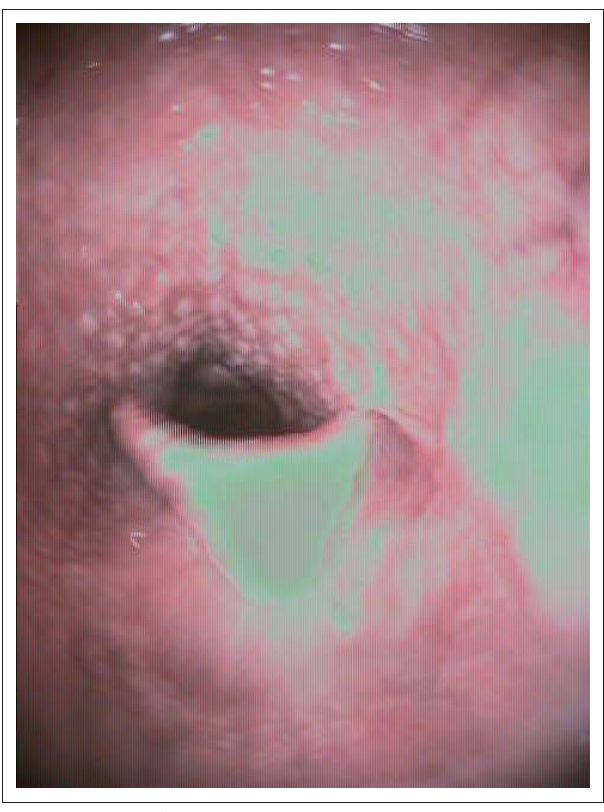
FIGURE 8: Single abnormality observed in the study: Nasopharyngeal